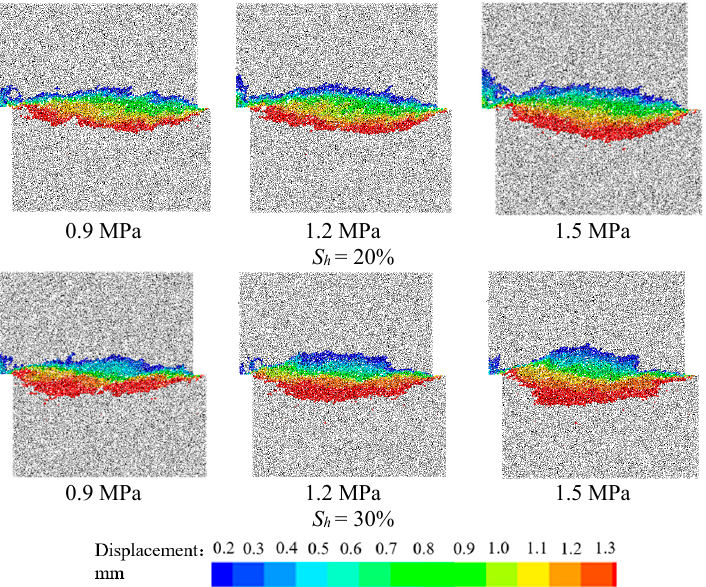
Figure 15. Shear zone range of natural gas hydrate deposits under different conditions with shear displacement of 1.4 mm.